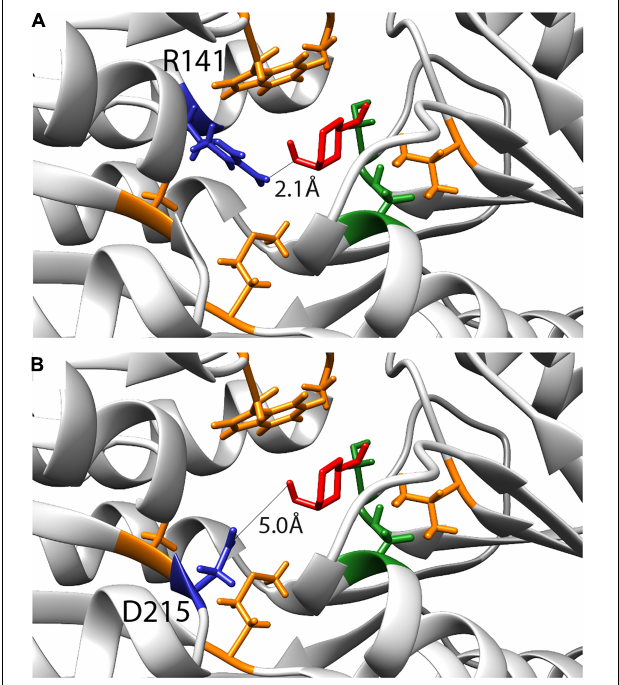
FIGURE 4 | Inferred binding pocket of DT016 in presence of 13CHD (in red) and with the substituted residues for ligand binding color-coded based on characteristics (non-polar- orange; polar- green). (A) Arginine at position 141, selected for site saturation mutagenesis, is highlighted in dark blue. Distance between 13CHD molecule and R141 is indicated. (B) As for (A) but for Aspartic acid at position 215.